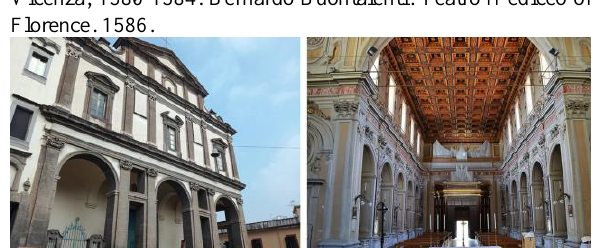
Figure 4 - From left, Domenico Fontana, Santa Maria della Stella’s church (1571), finished in 1734 by Domenico Antonio Vaccaro.